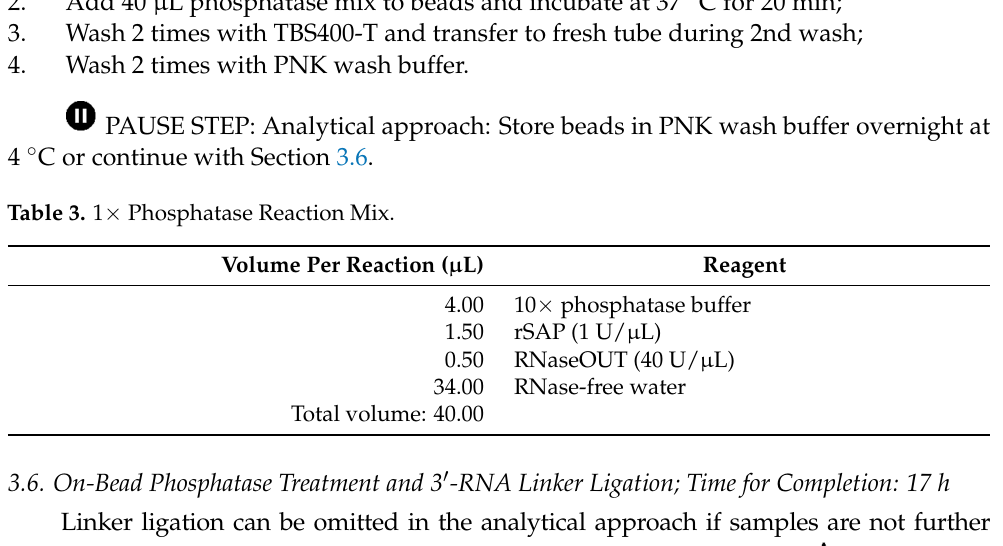
Table 11. PCR Scheme for Preamplification of cDNA.